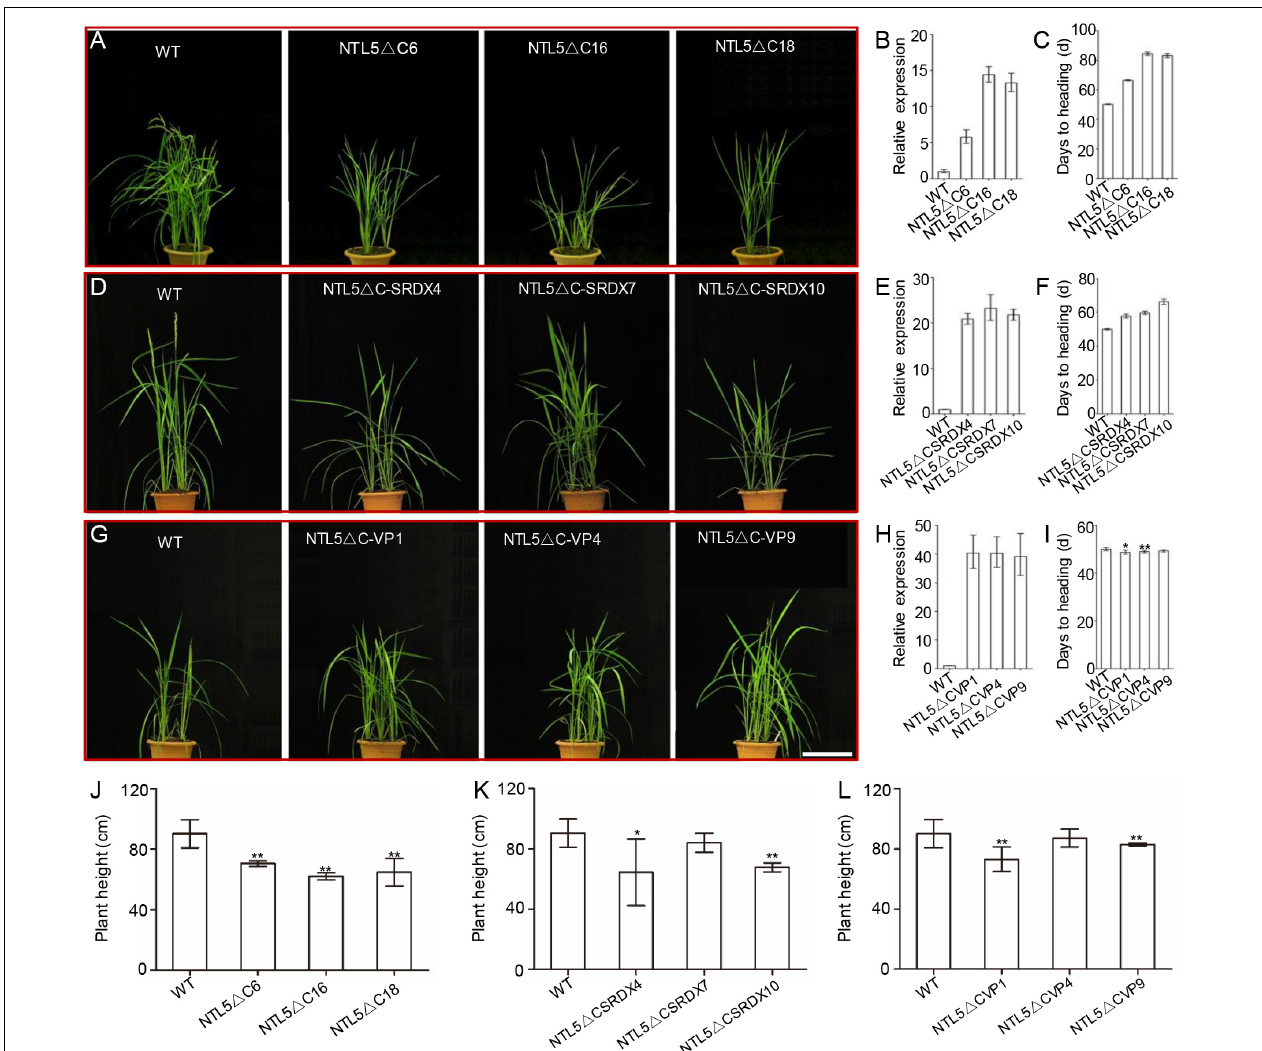
FIGURE 1 | Phenotypic and molecular characterization of the OsNTL5 (cid:49) C , OsNTL5 (cid:49) C-SRDX , and OsNTL5 (cid:49) C-VP transgenic lines of rice. (A) The phenotypes of 60-day-old WT and OsNTL5 (cid:49) C transgenic plants. Bar = 20 cm. (B) Relative expression of OsNTL5 in the OsNTL5 (cid:49) C transgenic lines. Values represent the means ± SD. (C) Days of heading to WT and OsNTL5 (cid:49) C under natural photoperiodic conditions. Values represent the means ± SD (standard deviation). The data were collected from 20 individual plants. (D) Phenotypes of 55-day-old WT and OsNTL5 (cid:49) C-SRDX transgenic plants. Bar = 20 cm. (E) Relative expression of OsNTL5 in the OsNTL5 (cid:49) C-SRDX transgenic lines. Values represent the means ± SD. (F) Days of heading to WT and OsNTL5 (cid:49) C-SRDX under natural photoperiodic conditions. Values represent the means ± SD. The data were collected from 20 individual plants. (G) Phenotypes of 55-day-old WT and OsNTL5 (cid:49) C-VP transgenic plants. Bar = 20 cm. (H) Relative expression of OsNTL5 in the OsNTL5 (cid:49) C-VP transgenic lines. Values represent the means ± SD. (I) Days of heading to WT and OsNTL5 (cid:49) C-VP under natural photoperiodic conditions. Values represent the means ± SD. Data were collected from 20 individual plants. (J) Plant height of WT and OsNTL5 (cid:49) C was measured 85 days after germination. Values represent the means ± SD, n = 15. (K) Plant height of WT and OsNTL5 (cid:49) C-SRDX was measured 85 days after germination. Values represent the means ± SD, n = 15. (L) Plant height of WT and OsNTL5 (cid:49) C-VP was measured 85 days after germination. Values represent the means ± SD, n = 15. ∗ P < 0.05, ∗∗ P <